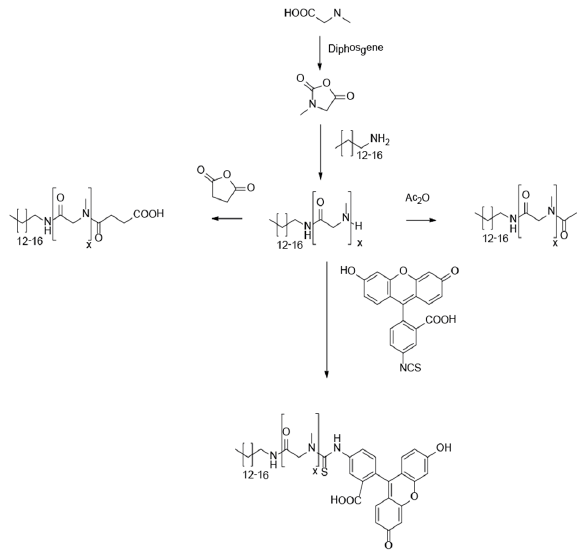
Table 2. Calculated HLB values and measured CMC.